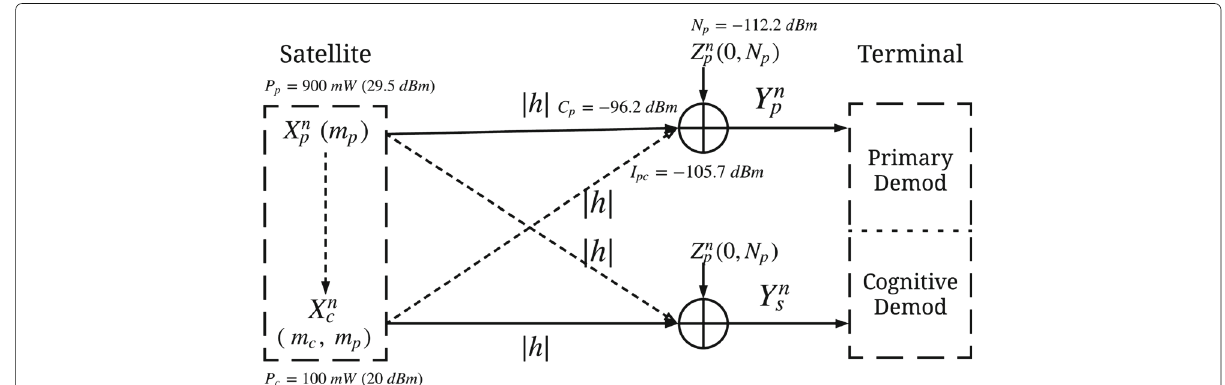
Fig. 12 Overlay model considering realistic satellite link budget